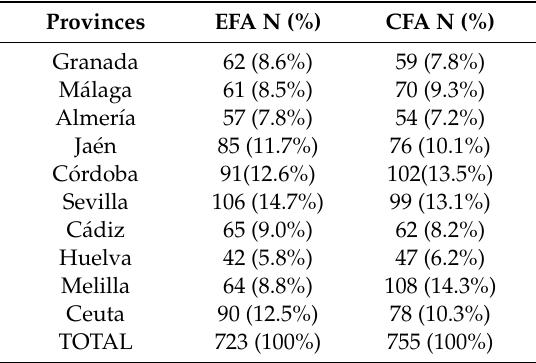
Table 1. Distribution of sample by